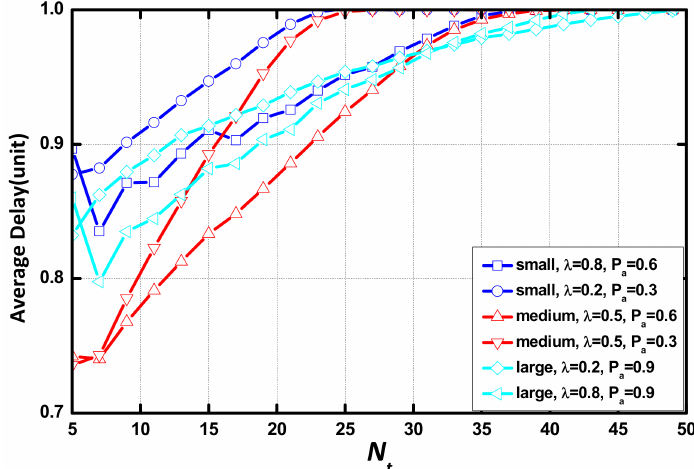
Figure 14. Ratio of the average delay of the AAR scheme and the common scheme vs. N t